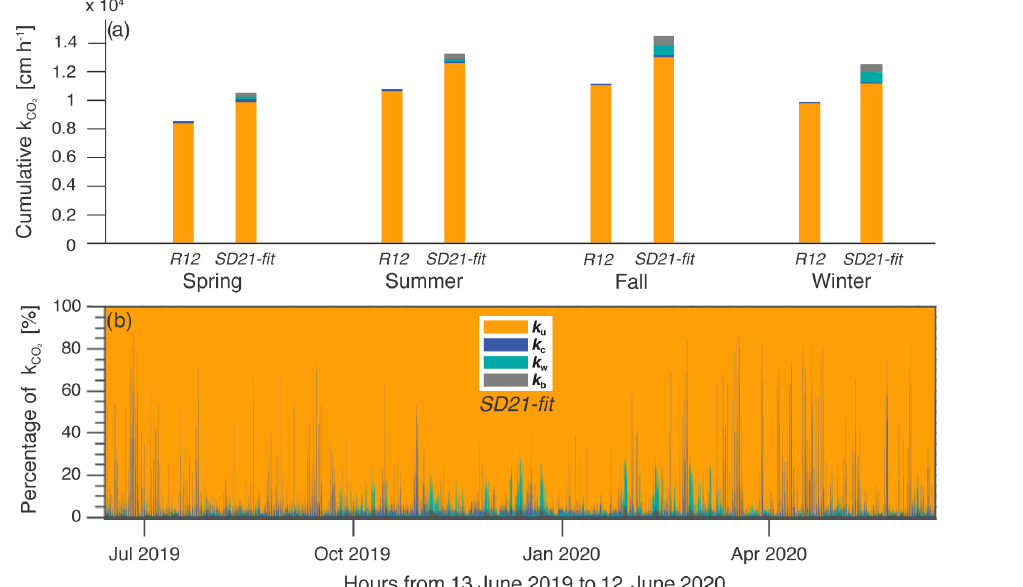
generated by two main processes ( k u and k c ) in R12 and four main processes ( k u , k c , k w , and k b ) in SD21-fit Figure 7. (a) Distribution of k CO 2 for each season: spring (April–May–June), summer (July–August–September), fall (October–November–December), and winter (January– February–March). The height of the bar represents the cumulative k CO by season for both models ( R12 and SD21-fit ). (b) Distribution of 2 four k generated by wind shear, convection, wave action, and bubble enhancement ( k u , k c , k w , and k b respectively) along the annual cycle. For the SD21-fit model, k u = SRM( ε u ), k c = SRM( ε u + ε c + ε w ) − SRM( ε u + ε w ), k w = SRM( ε u + ε c + ε w ) − SRM( ε u + ε c ), and k b .